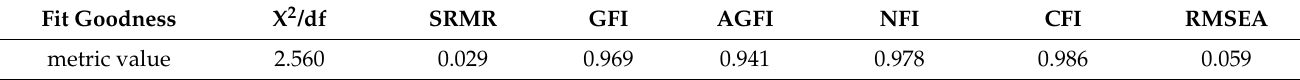
Table 4. The goodness-of-fit index of the hypothetical model.